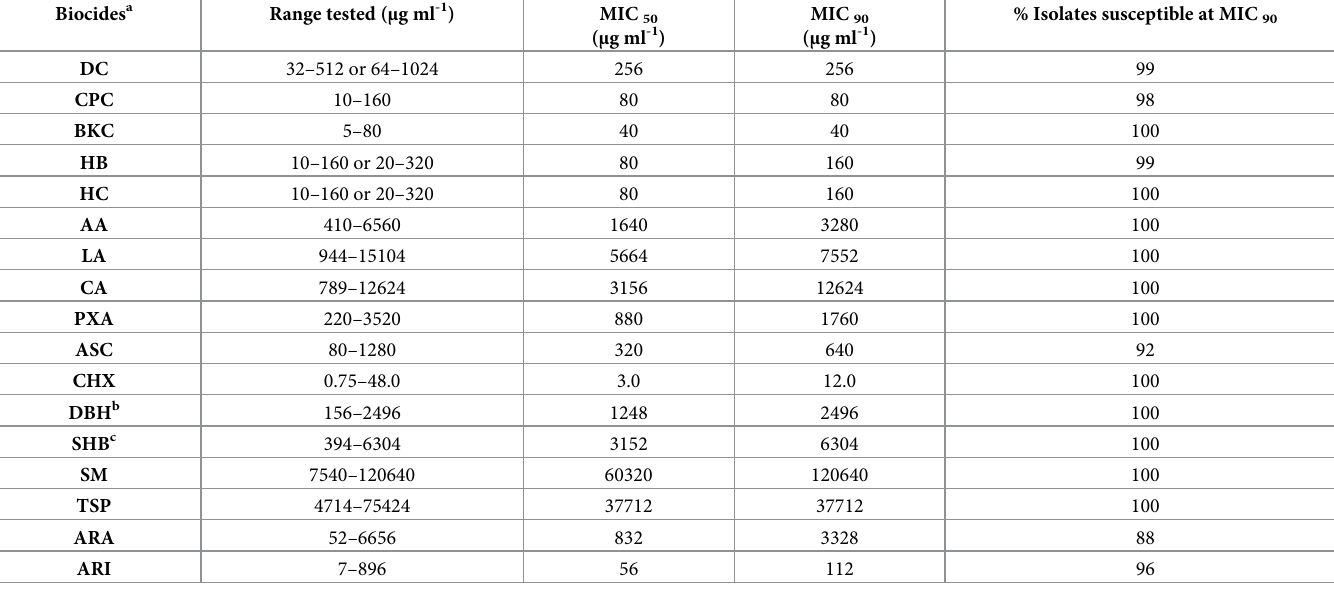
Table 1. Minimum inhibitory concentration (MIC) of 17 disinfecting chemicals / biocides for 88 MDR Salmonella isolates. Biocides